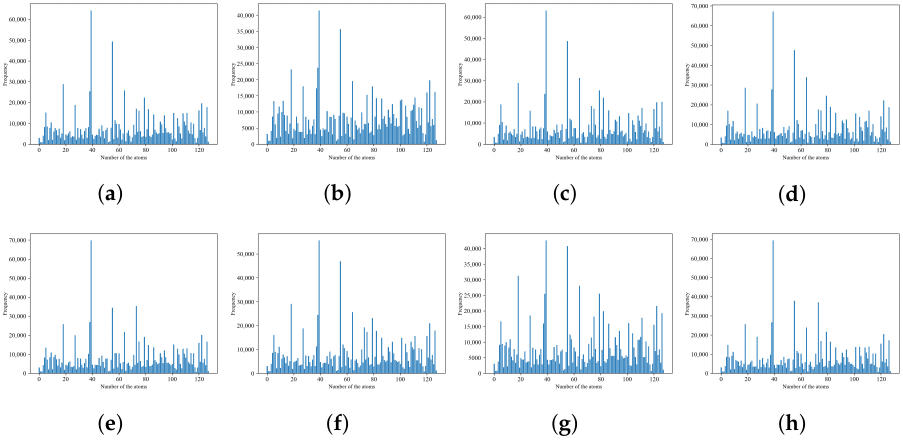
Figure 11. Histograms of occurrence number of each atom for image in Figure 1d with different distortion types. ( a ) Pristine image, ( b ) GN, ( c ) GB, ( d ) MB, ( e ) CC, ( f ) JPEG, ( g ) J2K, and ( h )